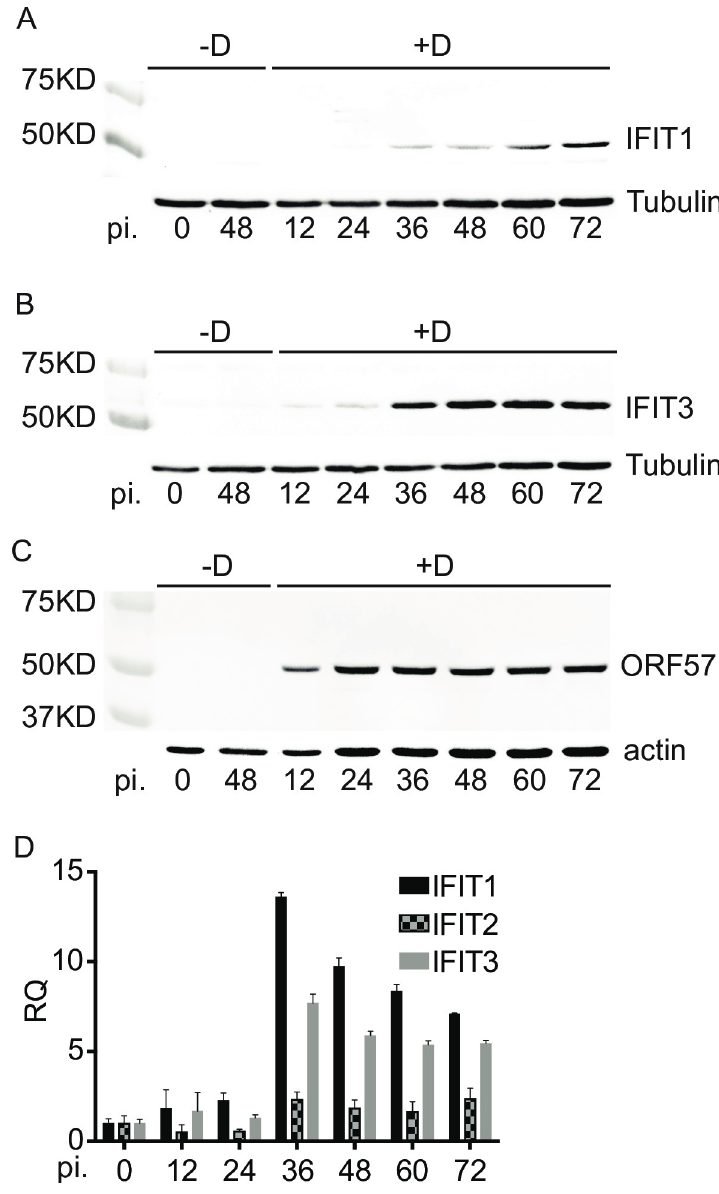
Fig 1. IFIT1 and IFIT3 expression is induced by KSHV lytic replication. KSHV-infected iSLK cells were untreated (-D) or treated with doxycycline (+D) to induce replication. Cells were harvested at different times post induction (pi) as shown. Immunoblotting of lysates from the cells was performed with anti-IFIT1, anti-IFIT3 and anti-ORF57 antibodies to measure IFIT1 (A), IFIT3 (B) and ORF57 (C) protein expression. Tubulin and actin blots are shown as a loading control. qPCR was performed to measure IFIT RNA expression in the samples from different time post induction as shown (D).